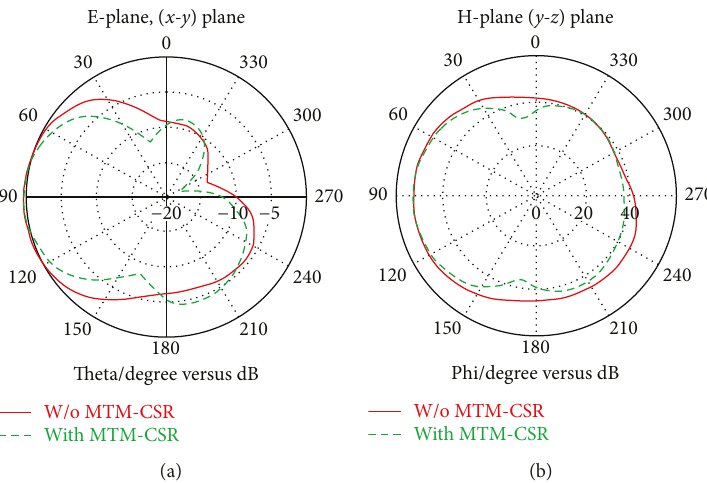
Figure 23: Radiation pattern of the E-shaped MIMO antenna system in parallel con fi guration: (a) E-plane and (b) H-plane.